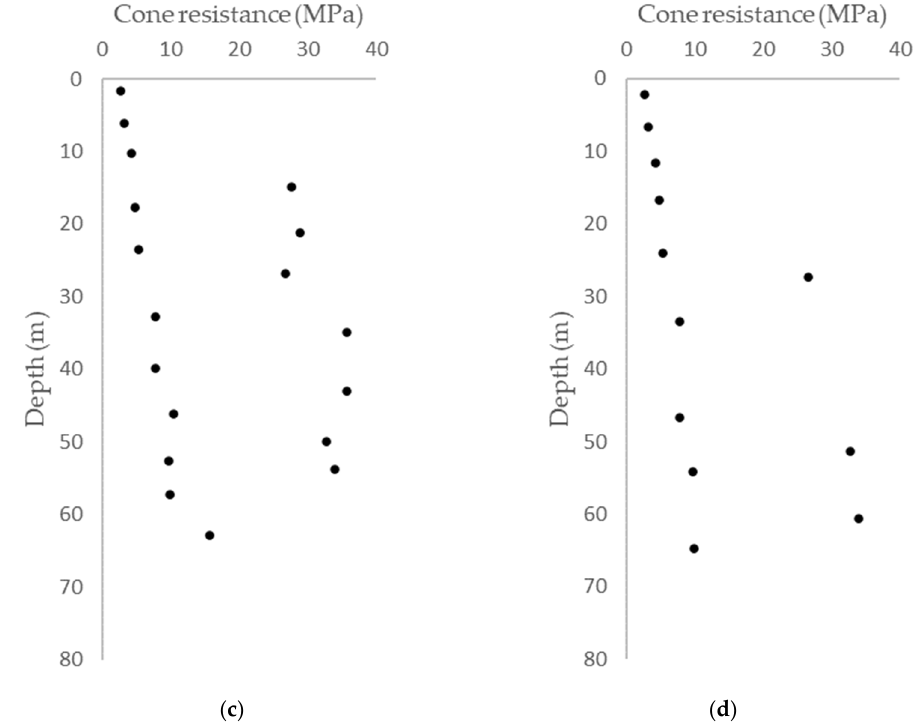
Figure 2. Cone penetration test results for ( a ) Test Pile 1, ( b ) Test Pile 2, ( c ) Test Pile 3 and ( d ) Test Pile 4.